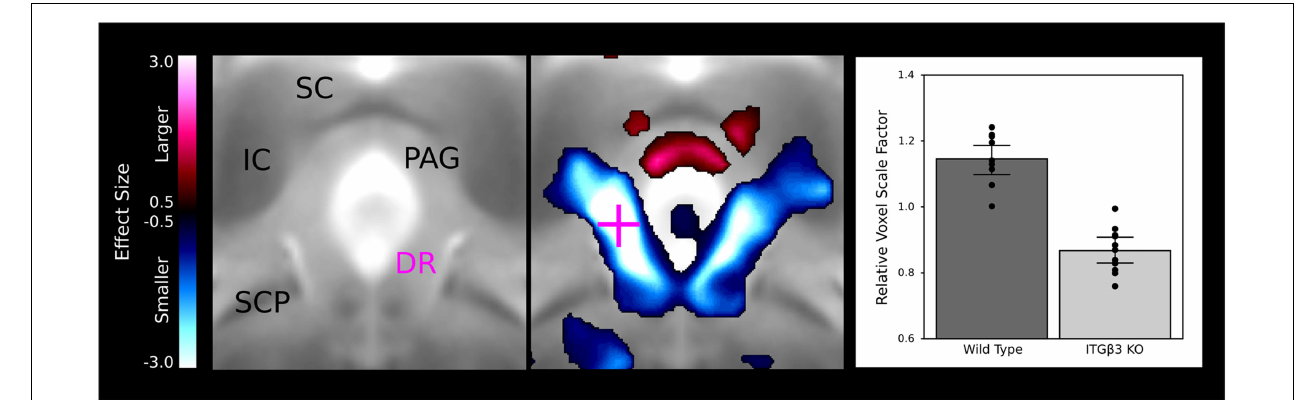
the bar graph on the left. IC, inferior colliculus; SC, superior colliculus; PAG, periaqueductal gray matter; SCP, superior cerebellar peduncle; and DR, dorsal raphe nuclei.